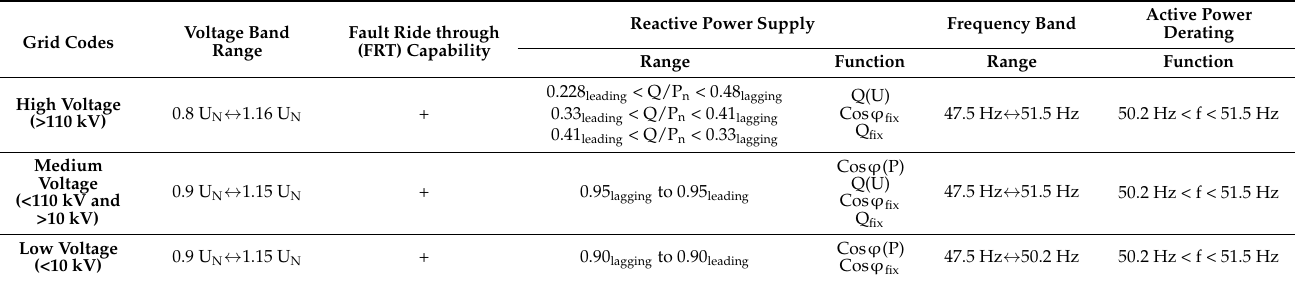
Table 2. German grid codes for grid-tied PV